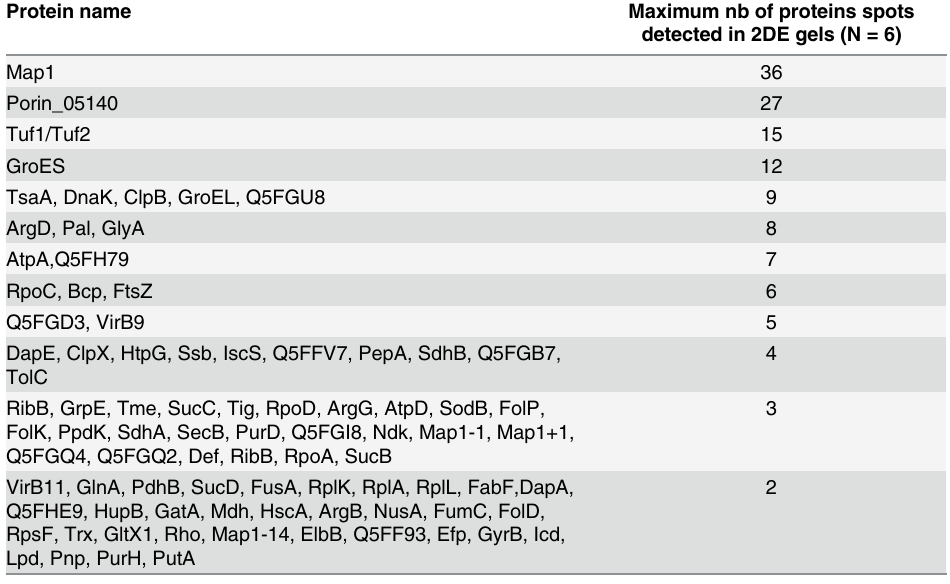
Table 1. Maximum number of spots per protein (proteoforms) detected by conventional 2DE-MALDI-- TOF/TOF (N = 6). Protein